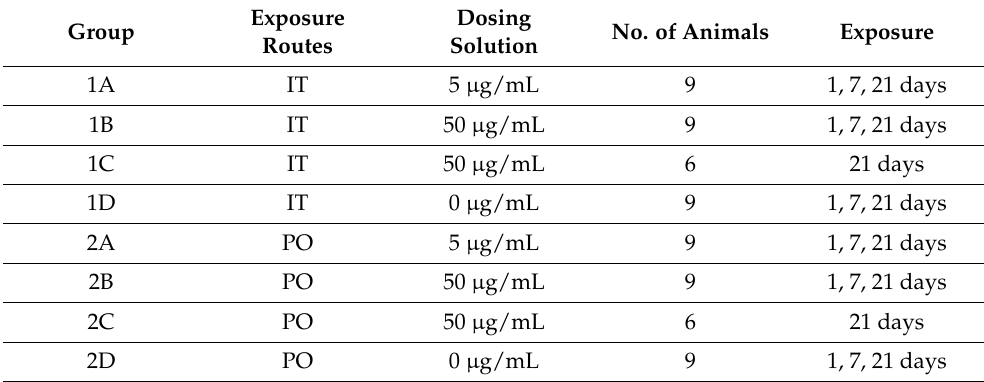
Table 1. Animal groups, doses and application routes of GPs. Exposure Dosing No. of Animals Group Routes Solution